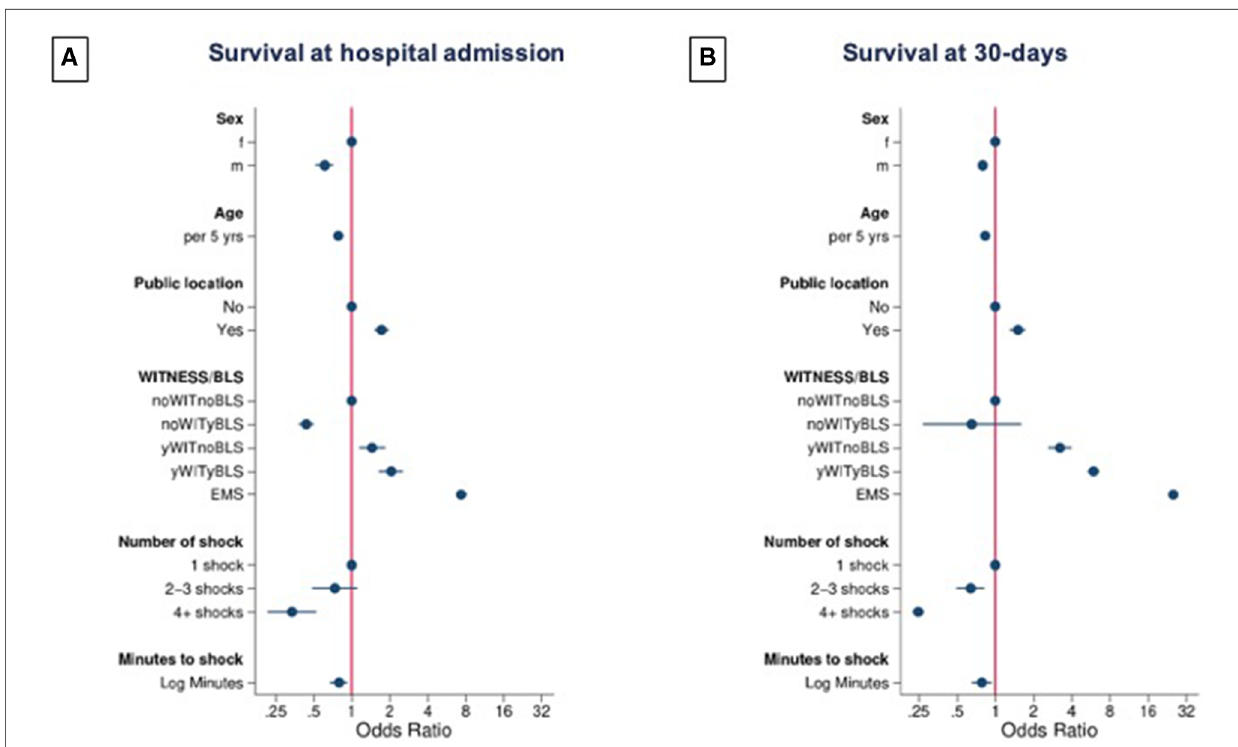
FIGURE 2 Forrest plot model of multivariable logistic regression analysis to assess independent predictors of survival. Panel A: predictors of survival at hospital admission. Panel B: predictors of survival at 30 days. Witness status and BLS before ambulance arrival were combined as follows: noWITnoBLS: bystander witnessed: no, BLS before ambulance arrival: no; noWITyBLS: bystander witnessed: no, BLS before ambulance arrival: yes; yWITnoBLS: bystander witnessed: yes, BLS before ambulance arrival: no; yWITyBLS: bystander witnessed: yes, BLS before ambulance arrival: yes; EMS: witnessed by